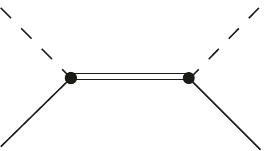
Figure 9. Tree level contribution to the dimension-six EFT. The double line denotes a mass eigenstate before